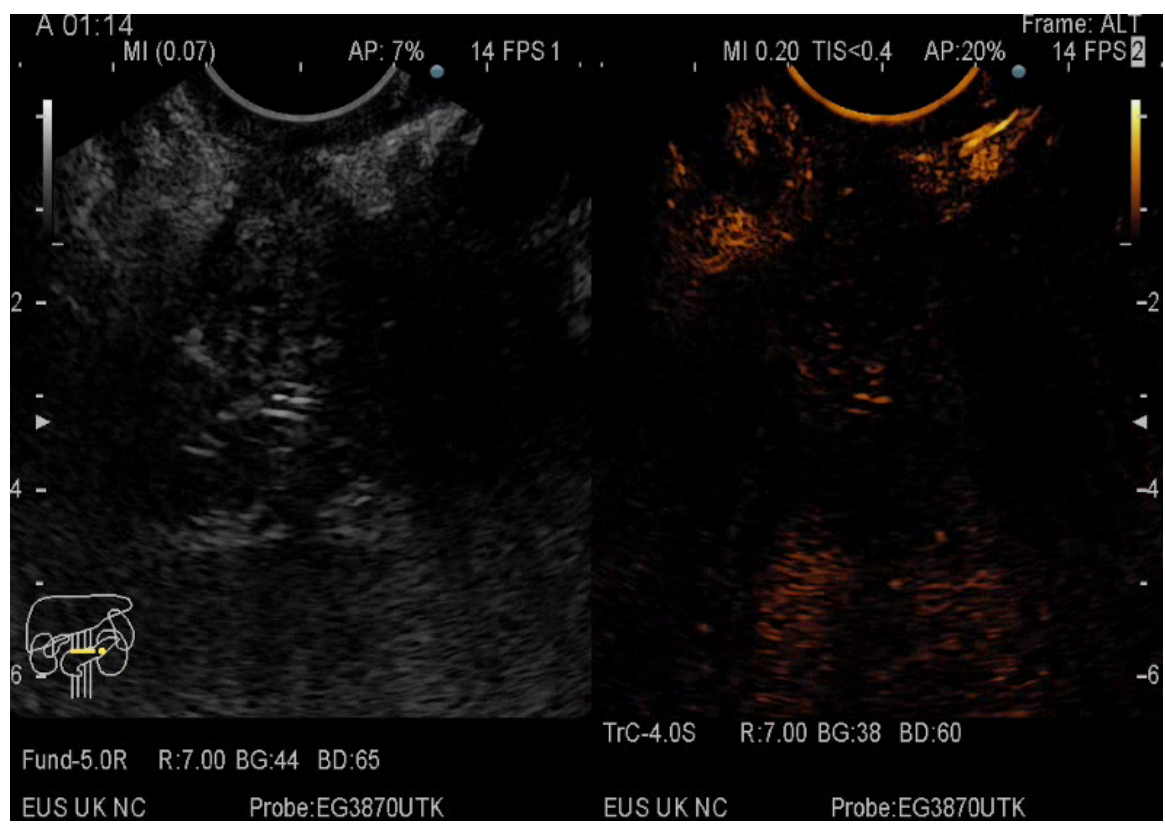
Figure 3. CE-EUS image of a PDAC showing a hypoenhancing solid mass in both arterial and venous phase.